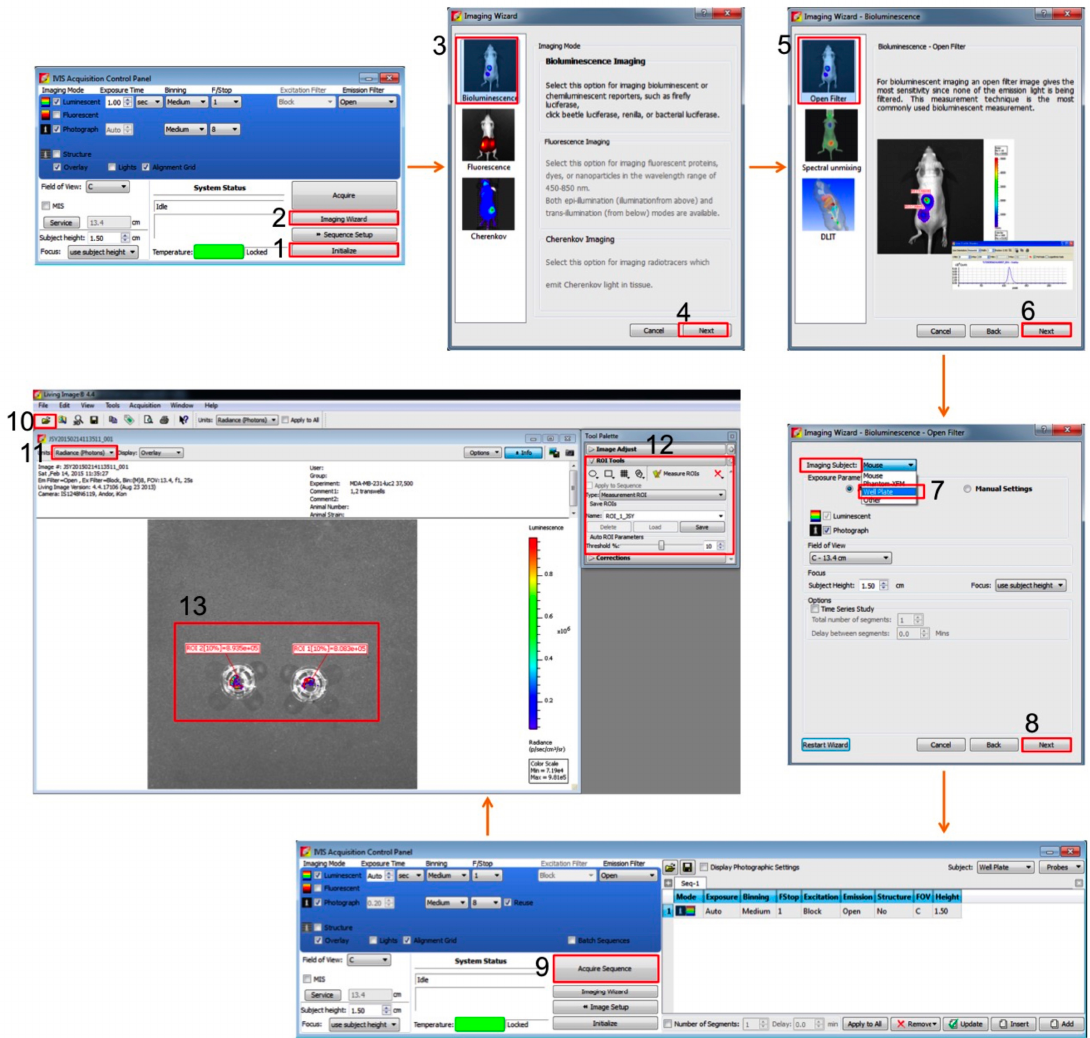
Figure 3. Flowchart of software procedure containing screen shots of key steps. Equipment setup is in no. 1–8 with red rectangles. Measurement and data analysis are in no. 9–12 with red rectangles. No. 13 is an example of bioluminescent signal from transwells.